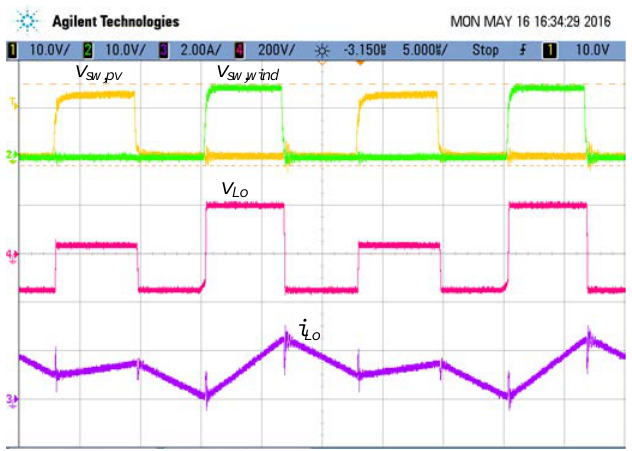
Figure 7. Measured waveforms while the output power is 500 W ( v sw,wind : 10 V/div, v sw,pv : 10 V/div, v Lo : 200 V/div, i Lo : 2 A/div, time: 5 μs/div).